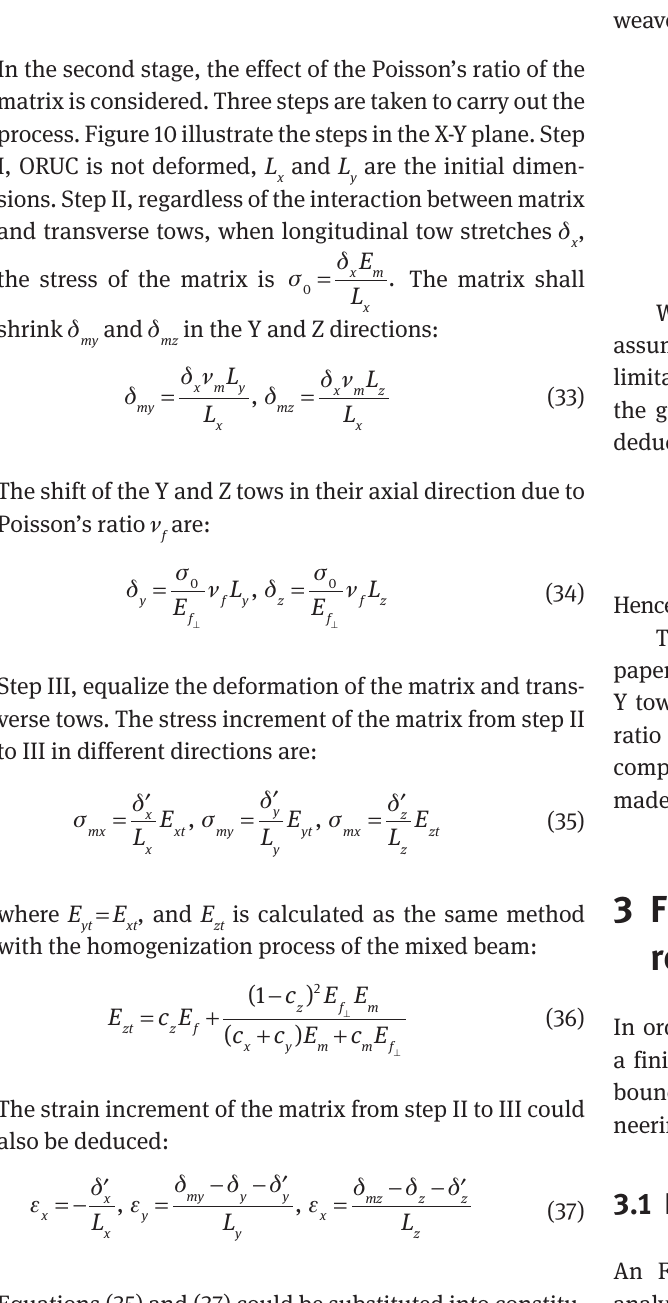
Figure 10: Steps to demonstrate the effect of Poisson’s ratio of matrix; only one Y tow is shown for easy reading. (A) Three steps. (B) Stress applied to tows from